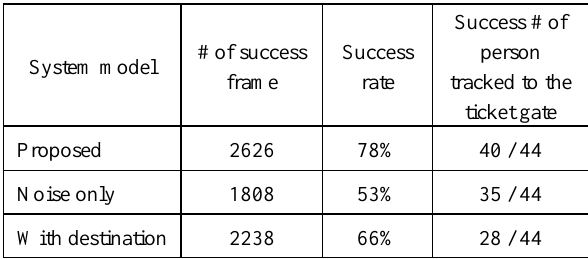
Table 6. Tracking result with comparison by system model